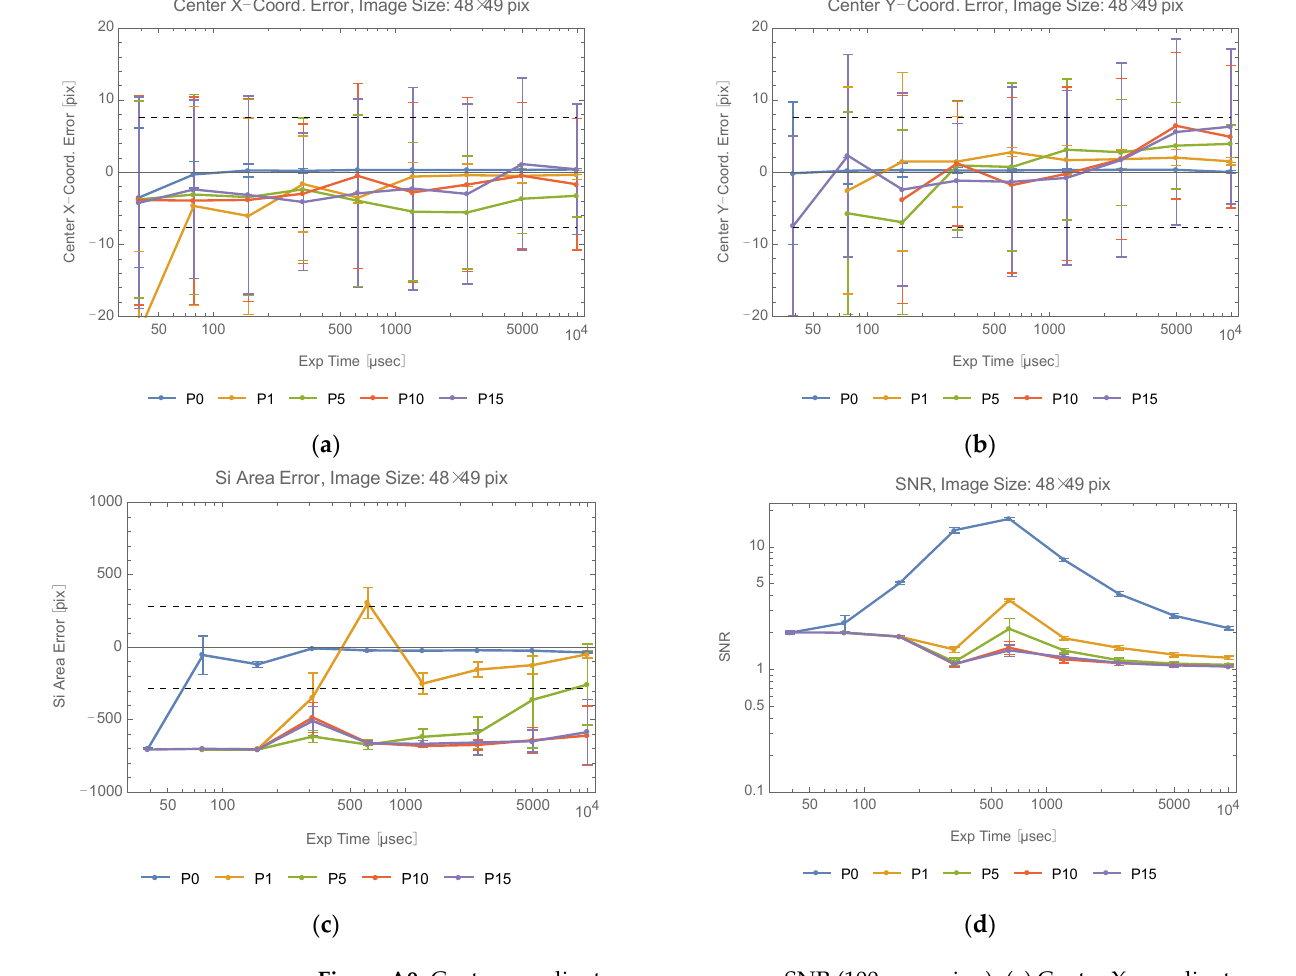
Figure A9. Center coordinate error, area error, SNR (100 averaging): ( a ) Center X-coordinate error; ( b ) Center Y-coordinate error; ( c ) Si area error; ( d ) SNR.